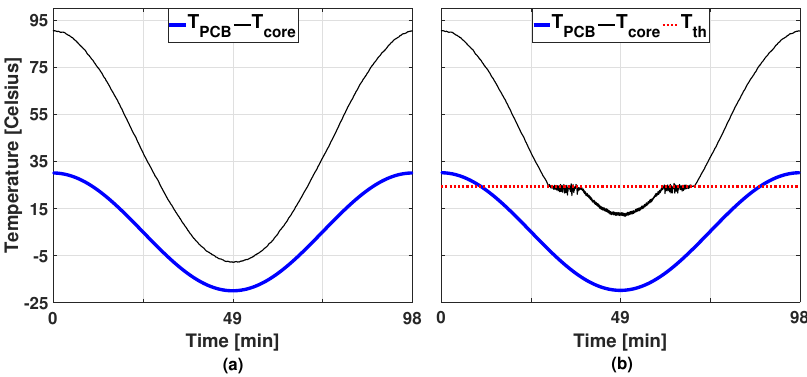
Figure 4. Temperature profiles of T core [ 0 ] caused ( a ) by Xian et al. [34] and ( b ) by the proposed technique without virtual task injections.